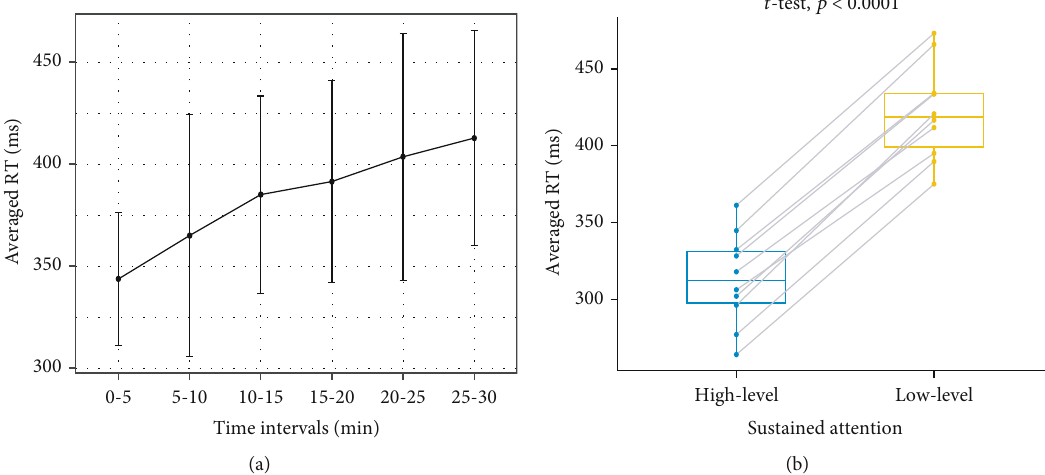
Figure 3: The behavioral results in Experiment 1. (a) The averaged RTs were increasingly longer with the experimental time going on. Note the length of error bars is the standard deviation. (b) The averaged RTs of high-level sustained attention trials were signi fi cantly faster than those of low-level sustained attention trials ( t ð 9 Þ = − 30 : 42 , p < 0 : 0001